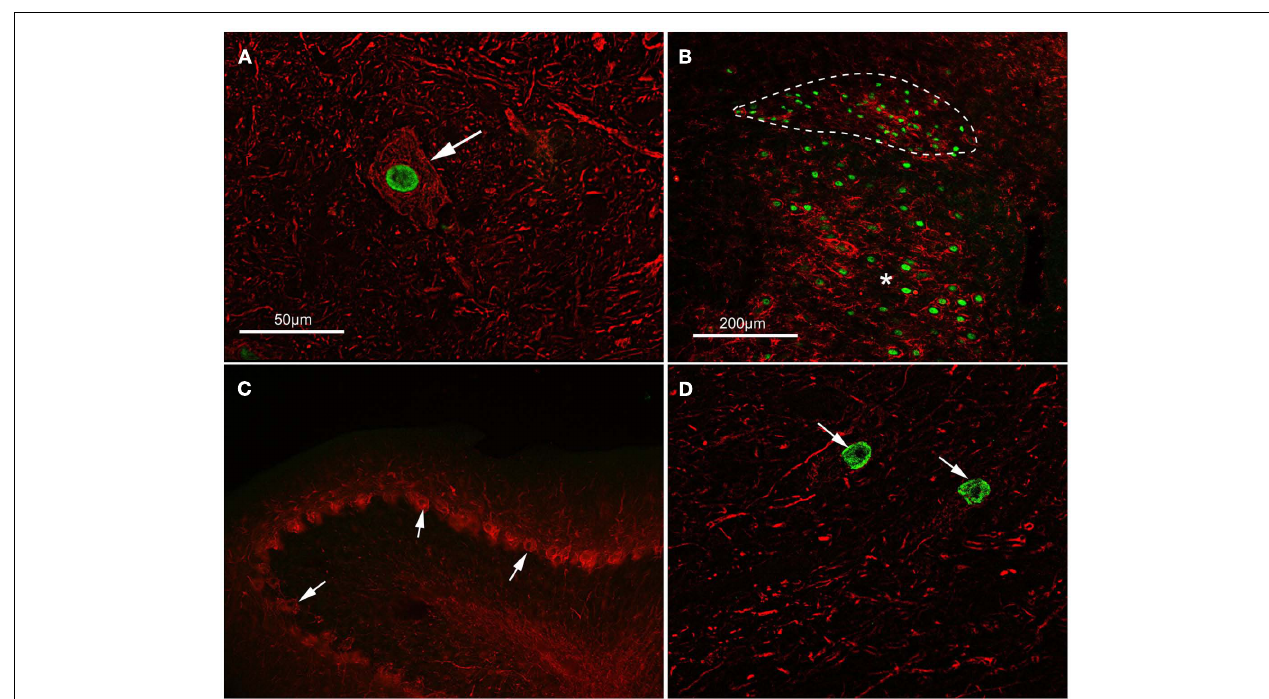
injury. CD11b immunoreactivity (red) shows reactive microglia around the axotomized neurons.The scale bar also applies to (C) . (C,D) Show the results of an experiment where a peripheral nerve graft was implanted into the cerebellum of an adult rat, axotomizing both deep nucleus neurons and Purkinje cells. Fourteen days after grafting, ATF3 (green) can be seen in the nuclei (arrows) of neurons within a cerebellar deep nucleus in (D) but not in the nuclei of Purkinje cells, arrowed in (C) . Deep nucleus neurons regenerate axons into grafts in the cerebellum but Purkinje cells do not do so; ATF3 is expressed only by the neurons which mount a regenerative response to axotomy. Neurofilament and calbindin immunoreactivity (red) has been used to identify Purkinje